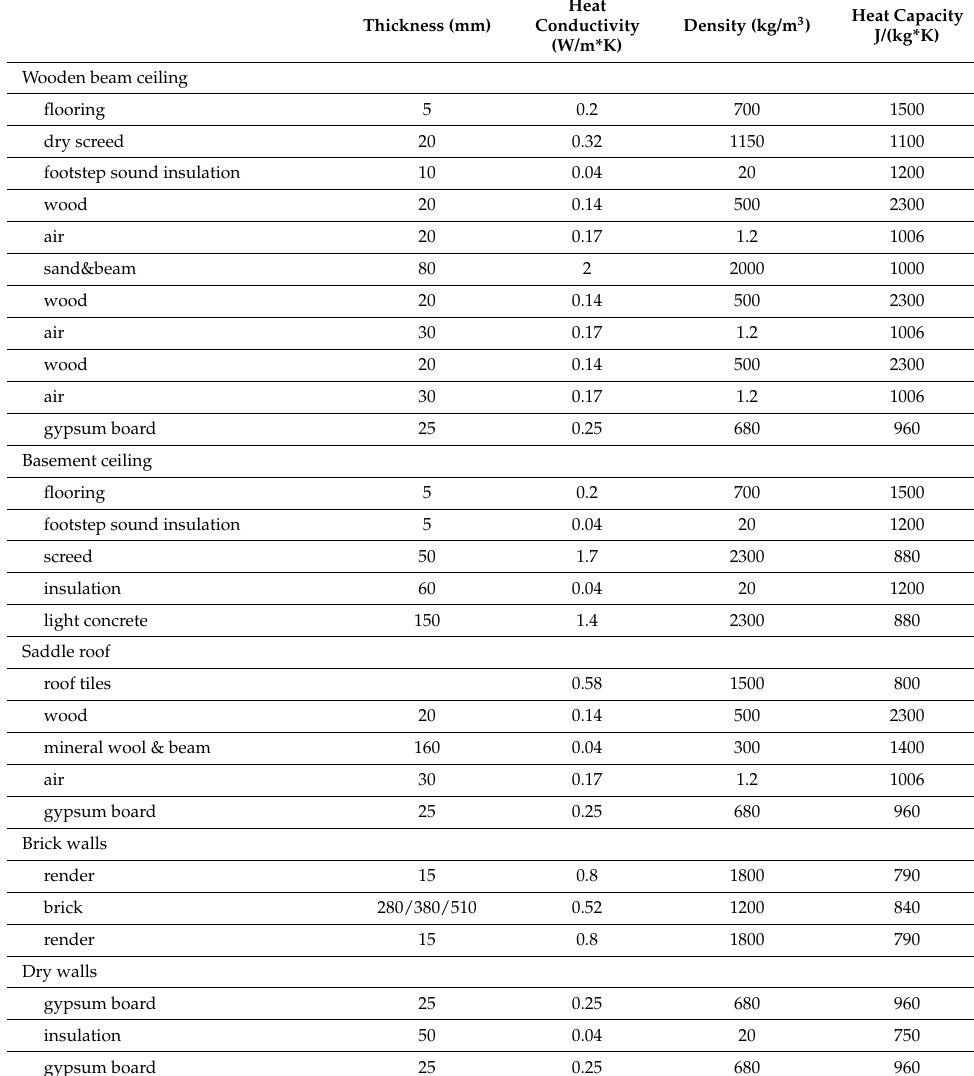
Table A3. Layers of the individual building components including layer thickness, heat conductivity, density and specific heat capacity. Heat conductivity, density and heat storage capacity was mainly taken from https://www.oekobaudat.de/ (accessed on 25 July